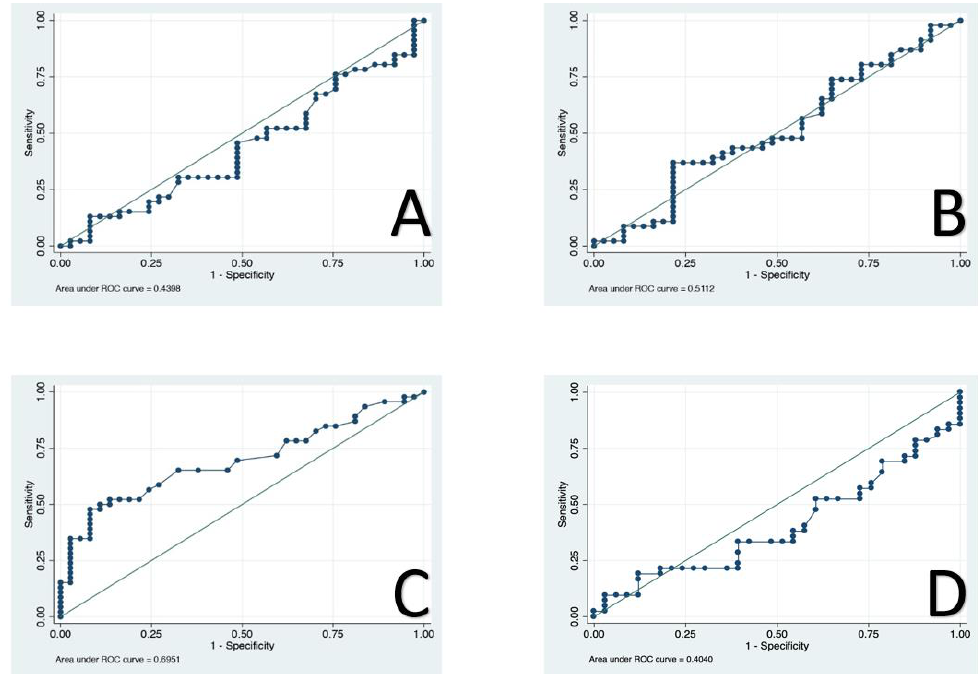
Figure 1. Receiver operator characteristic (ROC) curves of neutrophil-to-lymphocyte ratio (NLR) ( A ), platelet-to-lymphocyte ratio (PLR) ( B ), C-reactive protein to albumin ratio (CAR) ( C ), prognostic nutritional index (PNI) ( D ).